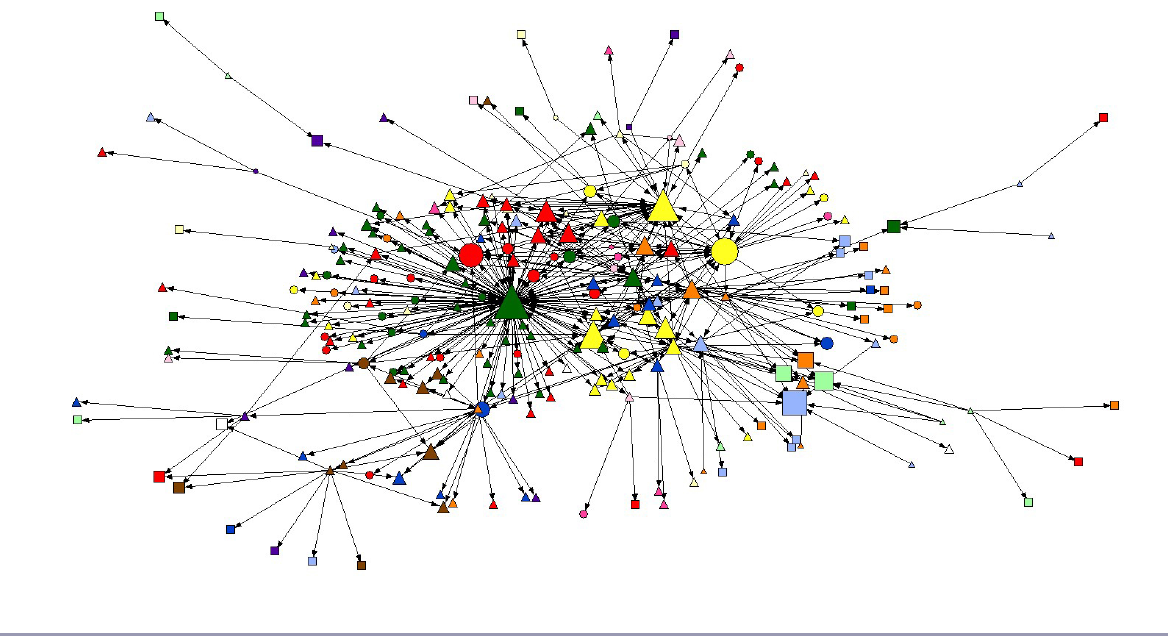
Fig. 2 . Communication network of the natural park of Sant Llorenç del Munt. Note: The size of the nodes indicates the indegree and the shapes indicate the sex (circle for women, a triangle for men, and a square for institutions). In addition, the following colors are used to denote the various categories: red (local administration); green (park managers); yellow (park employees); blue (agricultural sector); orange (scientific sector); purple (civic sector); pale green (conservationist sector); pale blue (leisure sector); pale yellow (environmental education/tourist sector); brown (forestry sector); pink (accommodation and restaurants); pale pink (other enterprises); and white